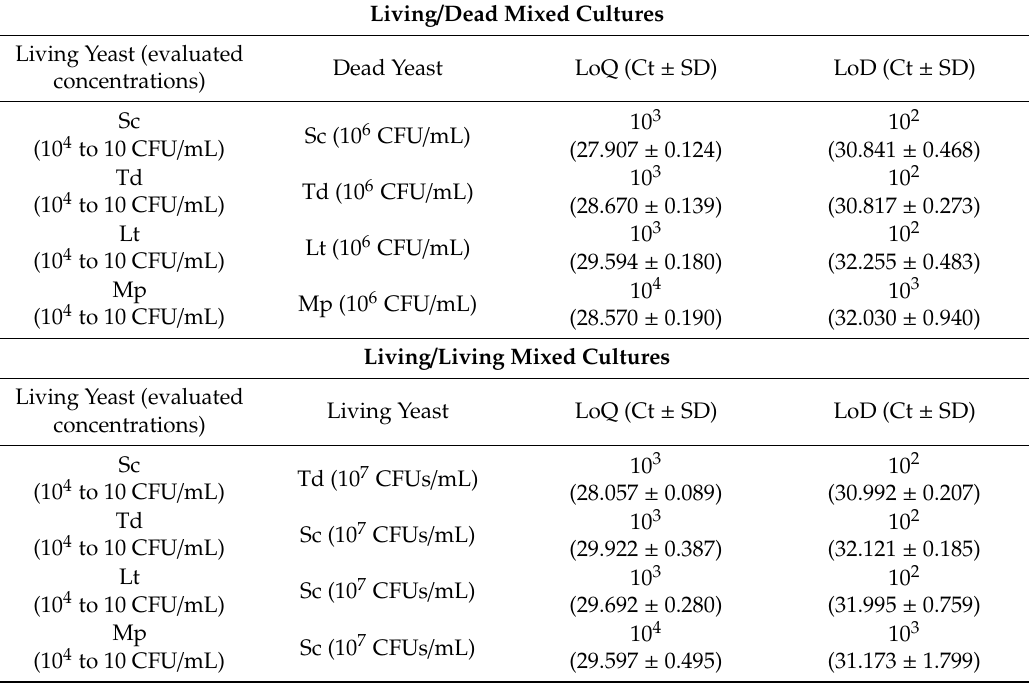
Table A2. Limit of Quantification (LoQ) and Limit of Detection (LoD) of S. cerevisiae (Sc), T. delbrueckii (Td), L. thermotolerans (Lt) and M. pulcherrima (Mp) obtained by PMAxx-qPCR. DNA from living cells of each species (Sc, Td, Lt or Mp) was mixed with DNA from dead cells of the same species (living / dead mixed cultures), or with DNA from living cells of another yeast species (living / living mixed cultures, Sc / Td, Td / Sc, Lt / Sc or Mp / Sc). Cycle threshold was calculated by triplicate and standard deviation was calculated (Ct ±